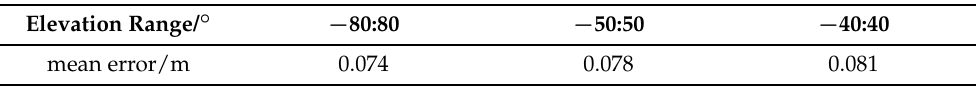
Table 5. NN models’ mean error with an elevation range of − 80:80, − 50:50 and − 40:40 when RTLS experiment measurements were